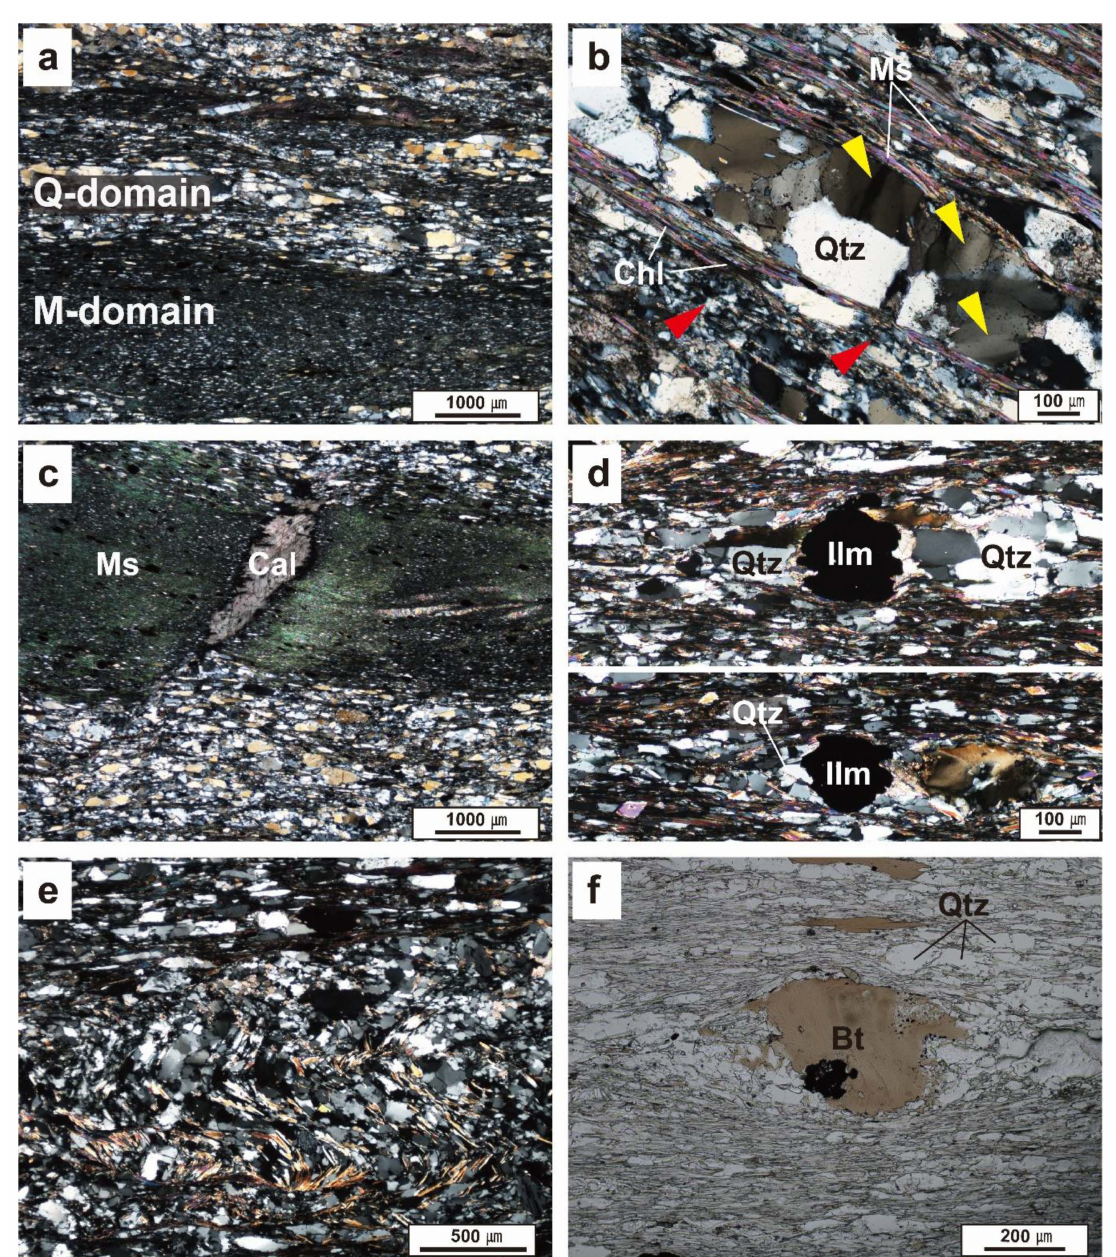
Figure 2. Optical photomicrographs of phyllite samples from the Geumseongri Formation. ( a ) Phyllite showing well- developed foliation with compositional layering of alternating Q-domain mainly composed of quartz and albite, and M-domain of mica (sample G103). ( b ) Quartz ribbon displaying undulose extinction and subgrain boundaries (sample G104). Yellow arrows represent undulose extinction of quartz. Red arrows represent recrystallized small grains of quartz. Qtz: quartz, Ms: muscovite. ( c ) Microcrack in M-domain filled with a calcite crystal (sample G103). Cal: calcite. ( d ) Pressure shadow of quartz around ilmenite porphyroclasts. Strain cap is partly observed (sample G102). Ilm: ilmenite. ( e ) Small-scale microfolds showing limbs and axial planes parallel to the foliation (G101). ( f ) Sheared biotite grain showing dextral shear sense (G102). Bt: